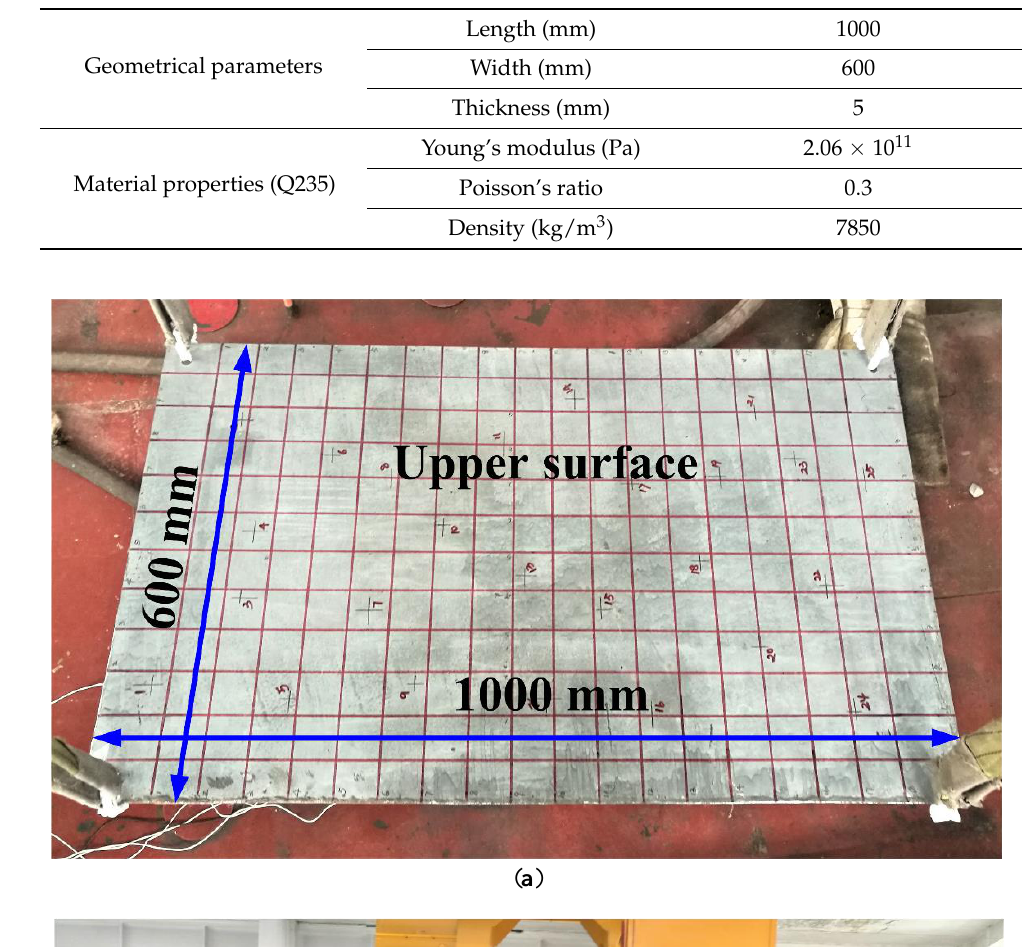
Table 1. Details of the experimental model.